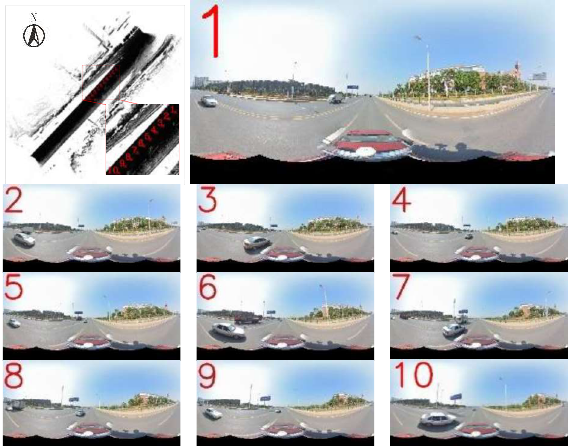
Figure 2. , plane map of the MMS LiDAR points (1600×1600, 320 m ×320 m ) and the panoramic image sequence, the red dots and number express 10 panoramic images (No.1-10).